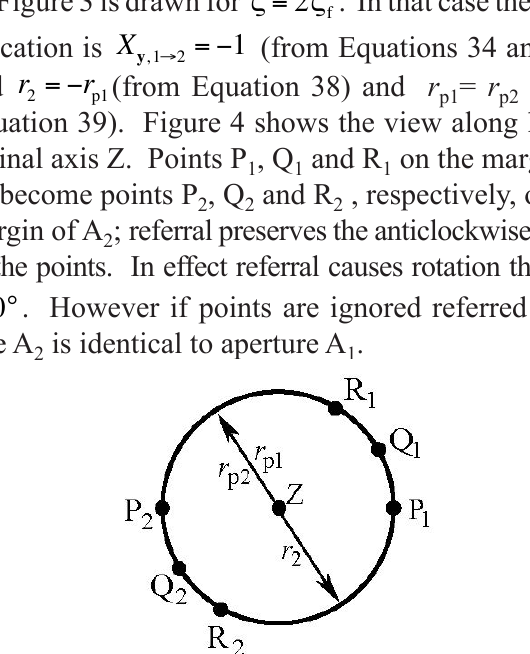
Figure 4 View along longitudinal axis Z of aperture A and 1 referred aperture A in Figure 3. A is circular with positive ra- 2 1 dius r . The scalar magnification associated with the referral p1 = − 1 and, hence, A = − r is X has (negative) radius r and y ,1 → 2 2 p1 2 = r positive radius r . Points P , Q and R in anticlockwise p2 p1 1 1 1 order on the margin of A become points P , Q and R , respec- 1 2 2 2 tively, also in anticlockwise order on the margin of A . In effect 2 referral causes rotation through 180 ° .